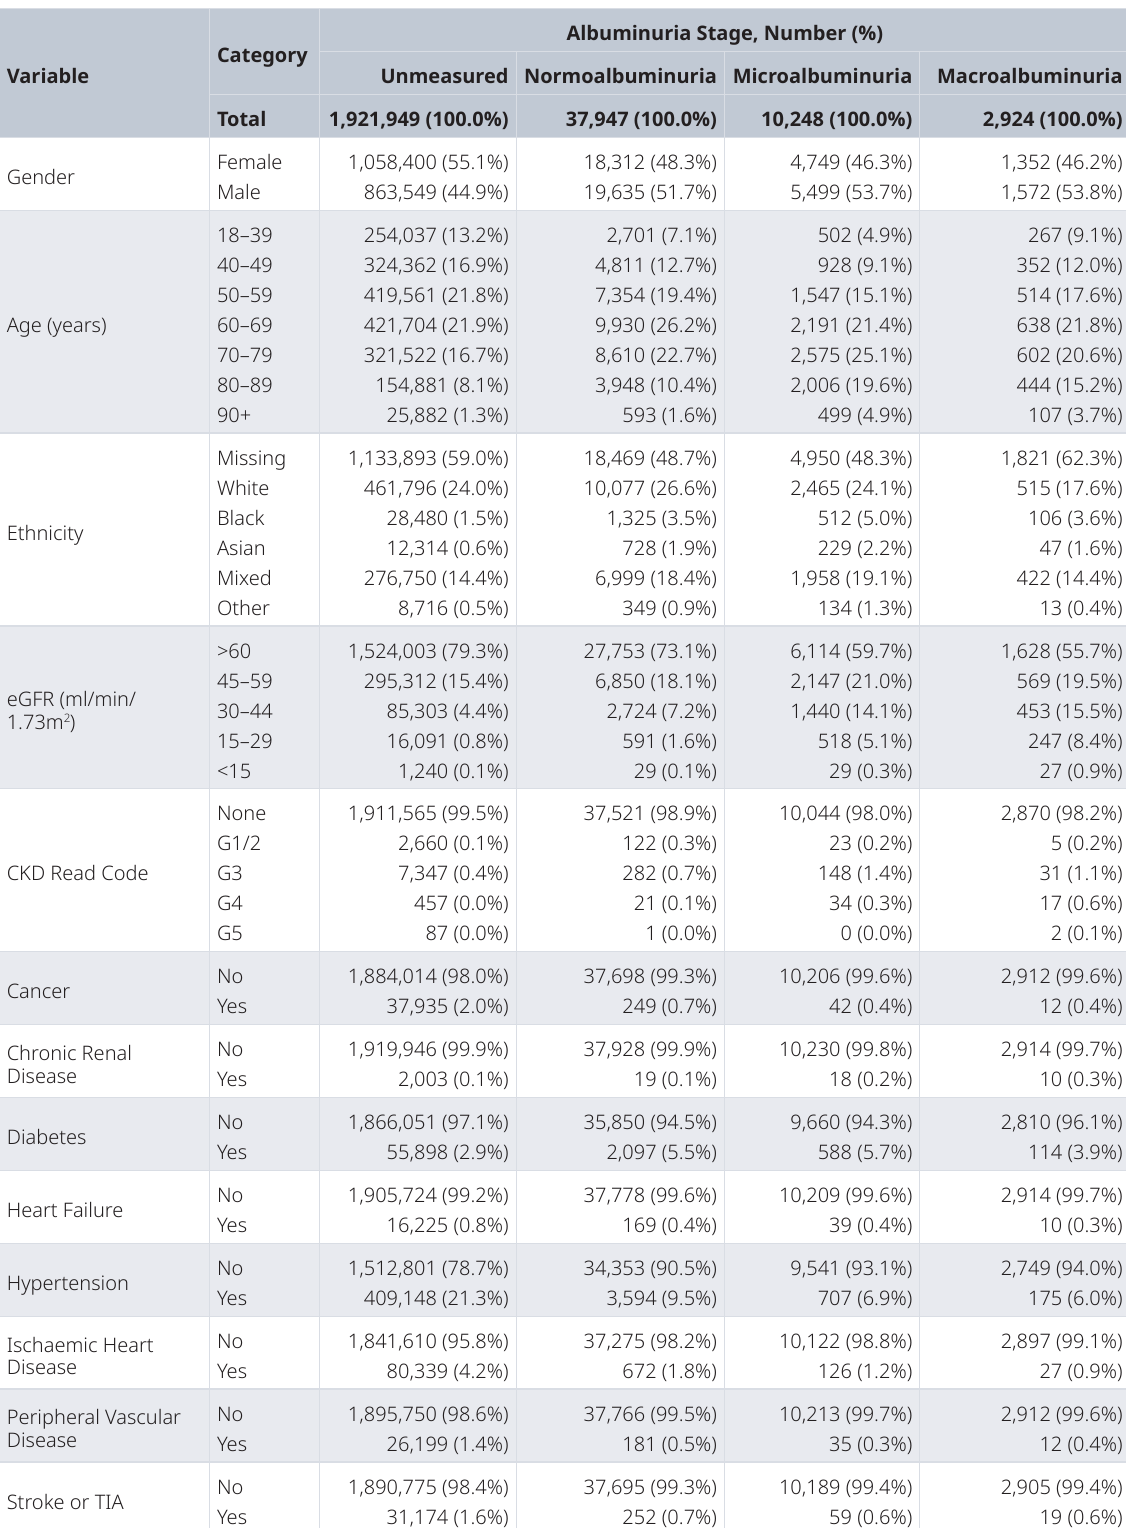
Table 1. Patient characteristics at baseline, by albuminuria stage.